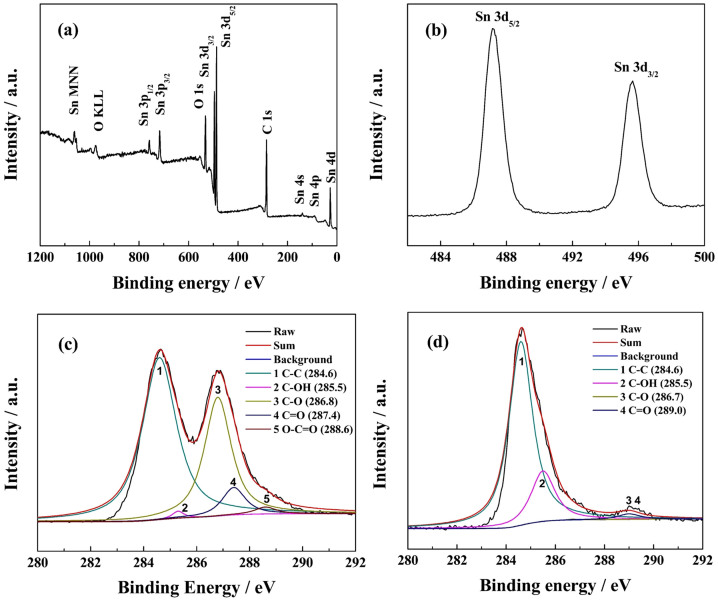
XPS spectra of graphene and SnO2/graphene.(a) general XPS spectrum of SnO2/graphene, (b) Sn 3d XPS spectrum of SnO2/graphene, (c) C 1s XPS spectra of graphite oxide and (d) C 1s XPS spectra of SnO2/graphene.